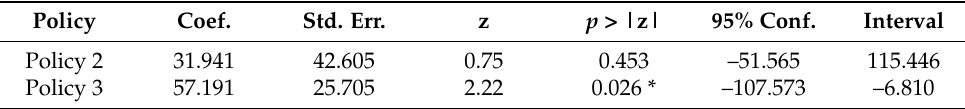
Table 5. Results of the RD method of pollutant concentration on restriction days. Policy Coef. Std.